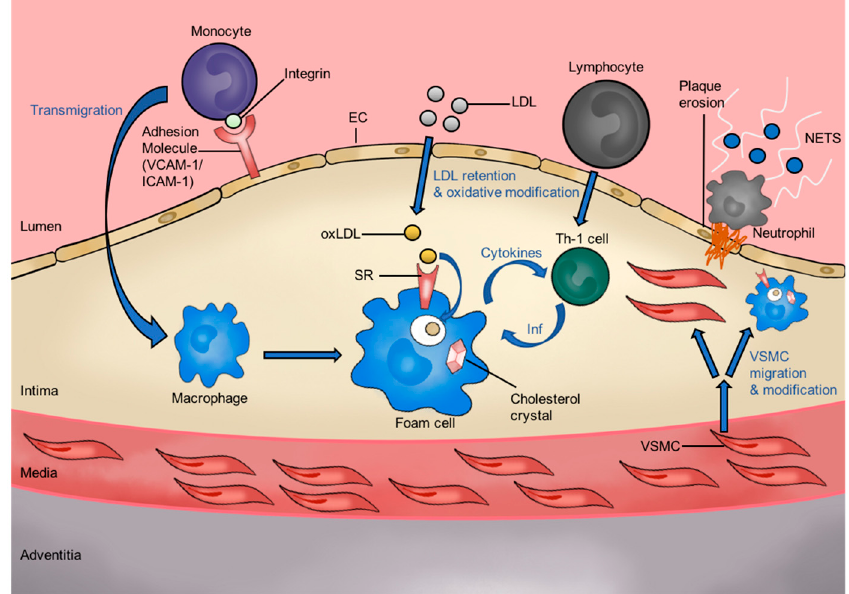
Figure 1. Key events in atherosclerotic plaque initiation. Blood LDL can accumulate within the arterial wall, in the sub-endothelial intima. This accumulated LDL can be chemically modified or oxidized: this new lipid particle species (e.g., oxLDL) promotes chronic inflammation, which promotes the trans-endothelial migration of immune cell types and foam cell development. Abbreviations: endothelial cell, EC; intercellular adhesion molecule-1, ICAM-1; interferon- γ , IFN γ ; low-density lipoprotein, LDL; Neutrophil extracellular traps, NETS; oxidized low-density lipoprotein, oxLDL; scavenger receptor, SR; T- helper 1 cell, Th1; vascular cell adhesion molecule-1, VCAM-1; vascular smooth muscle cell, VSMC.